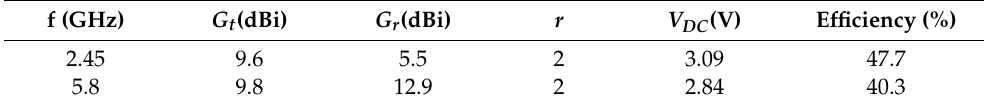
Table 2. Measured results of the rectenna performance.